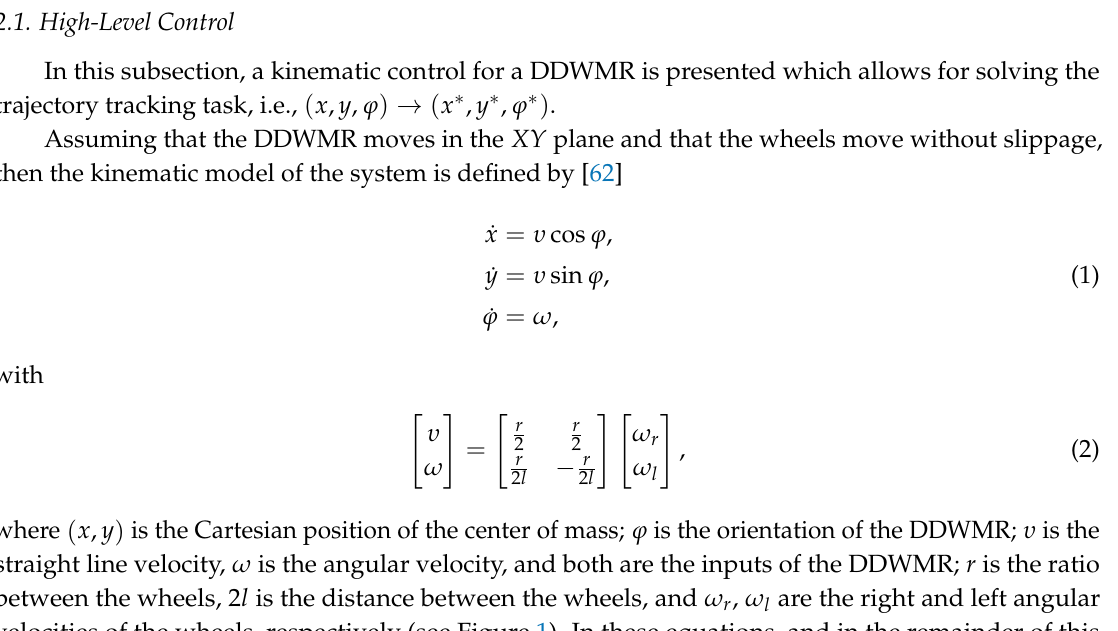
Figure 1. Differential drive wheeled mobile robot(DDWMR)